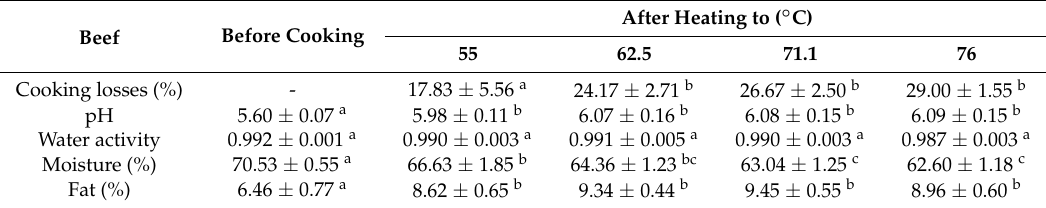
Table 1. Cooking losses, pH, water activity, and moisture and fat contents of non-intact course ground beef patties before and after cooking to various internal end-point